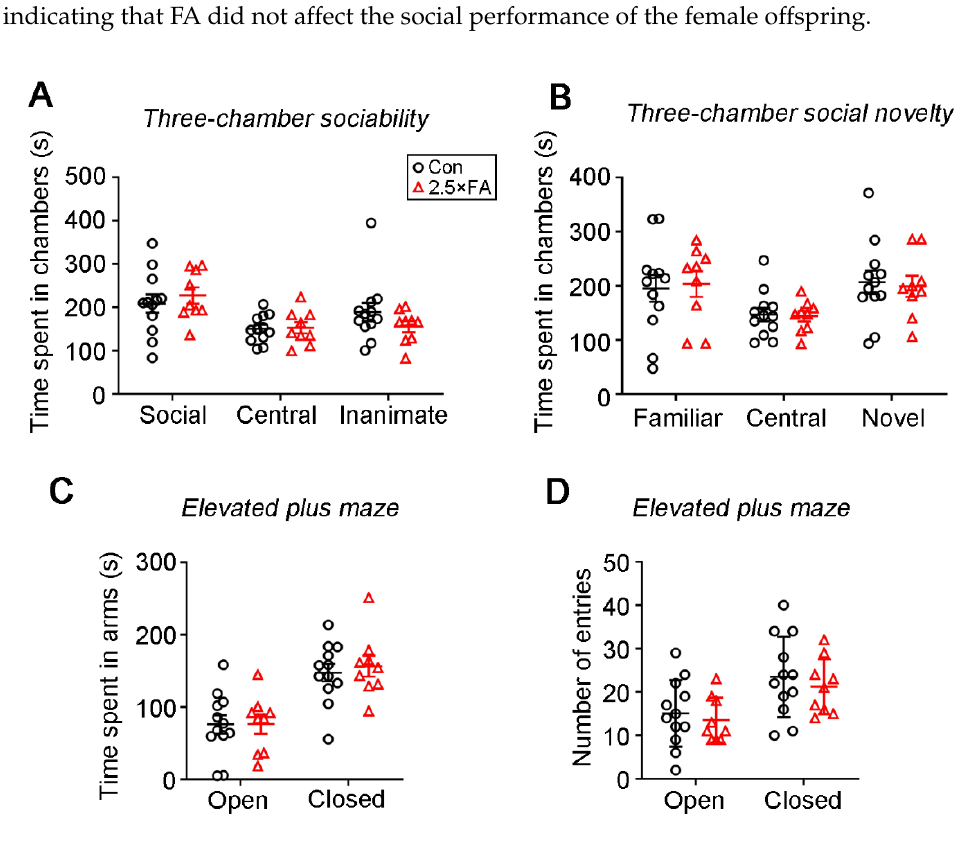
Figure 2. 2.5 × FA did not affect the sociability and anxiety-like behavior of the female offspring. ( A , B ) In the three-chamber social approach and social novelty test, the time of mice spent in different chambers during the sociability phase ( A ) or the social novelty phase ( B ) were recorded. ( C , D ) In the elevated plus maze, the time of mice spent in the closed or open arms ( C ) and the number of entries ( D ) into the closed or open arms were recorded. Con, n = 12; 2.5 × FA, n = 9. Next, the mice were assessed for anxiety-like behavior using the elevated plus-maze. closed arms was not different from that of the control mice (Figure 2C, FA F 1, 38 = 0.1213, p = 0.7295; Arm F 1, 38 = 33.44, p < 0.0001; FA × Arm F 1, 38 = 0.1059, p = 0.7466; Figure 2D, FA F 1, 38 = 0.6638, p = 0.4203; Arm F 1, 38 = 11.86, p = 0.0014; FA × Arm F 1, 38 = 0.0258, p = 0.8733), suggesting that 2.5 × FA supplementation did not induce anxiety in the female offspring in the elevated